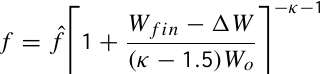
Fig. 2. Characteristics of 180 keV O + fluxes in the equatorial plane at t = 9min, viewed from the north. The color represents the en- ergy gain of an ion traced backwards from the given location; this energy gain is also a measure of the flux increase at the given lo- cation. The four panels correspond to four different flux directions. The white contours represent the magnitude of the cross-tail electric field, and the black line shows the magnetic neutral line at t = 9min. The length unit here and in all other simulation figures is 1 R E . The colored individual lines show projections of orbits ending at the point of the arrow at t = 9min, illustrating orbits with high en- ergy